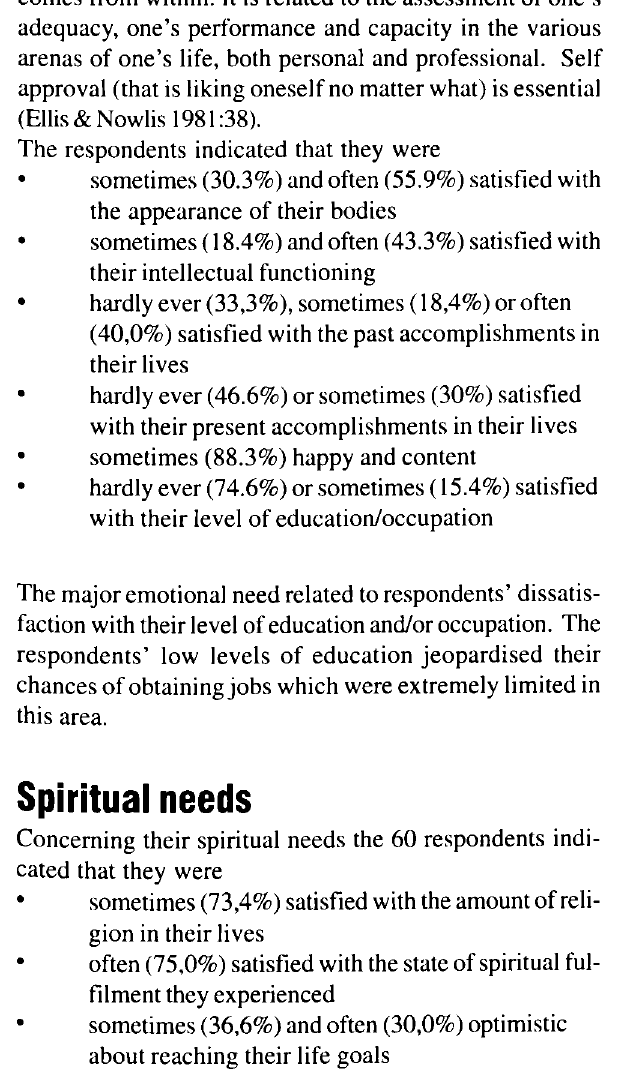
Table 1 : Internal and external support systems (n=60)